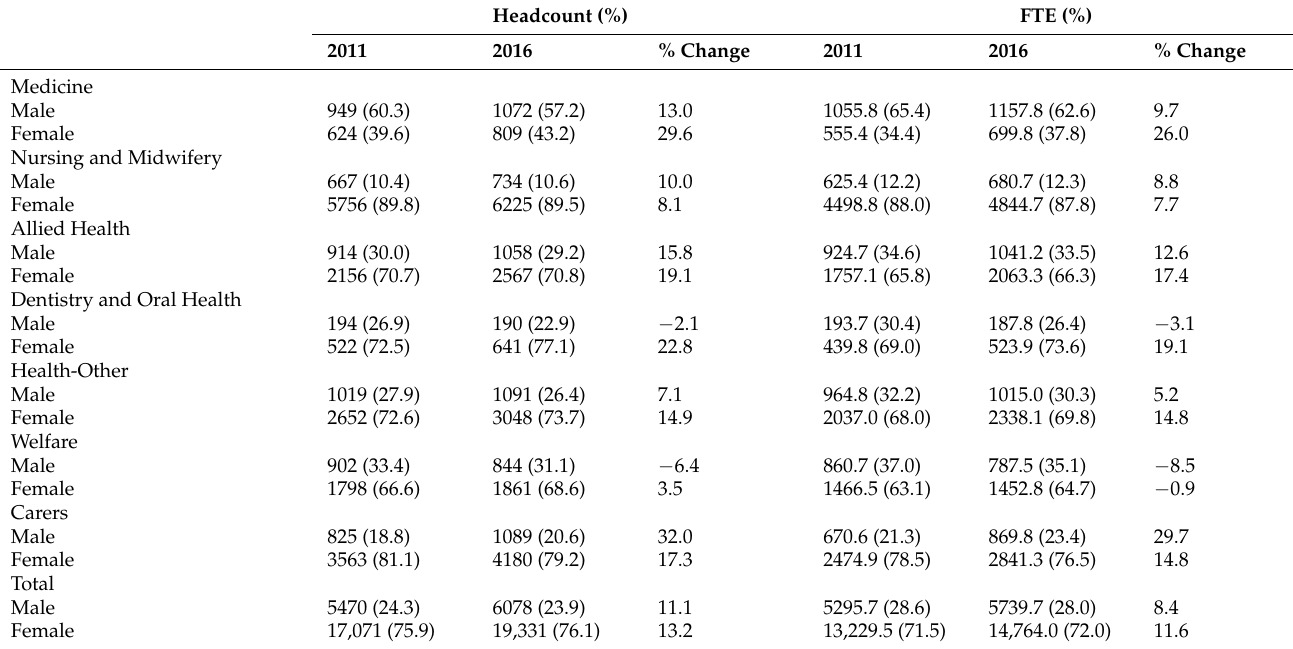
Table 4. Changes in gender composition of the Tasmanian health, welfare and care workforce between 2011 and